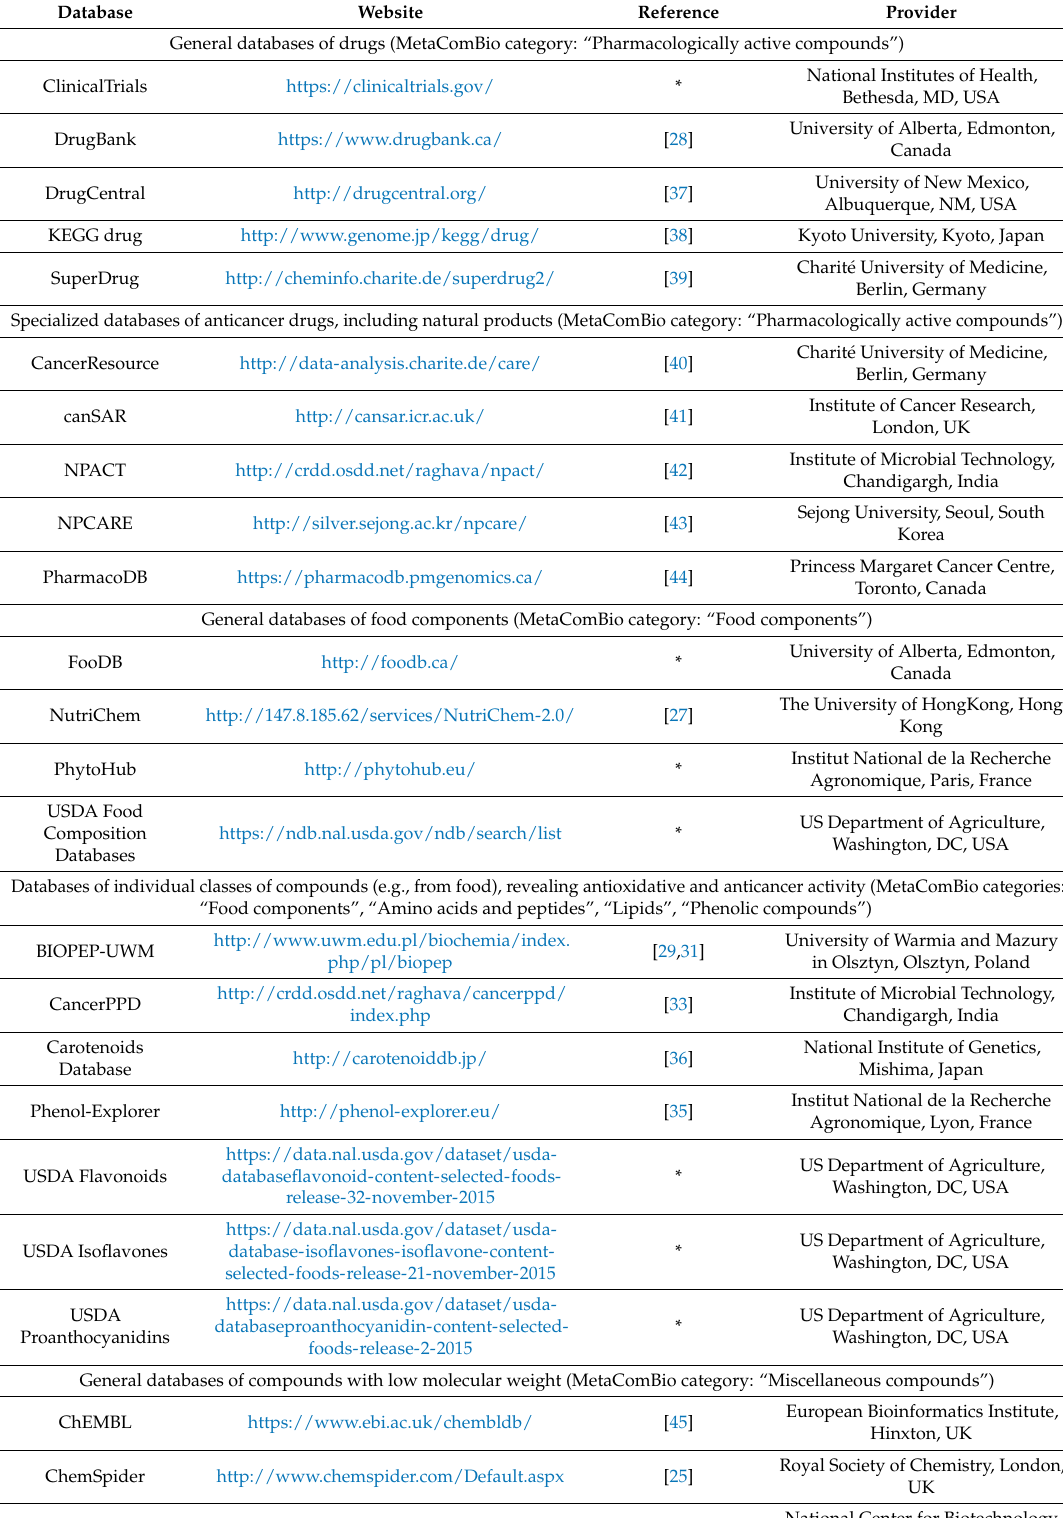
Table 1. Web addresses of databases containing information about anticancer